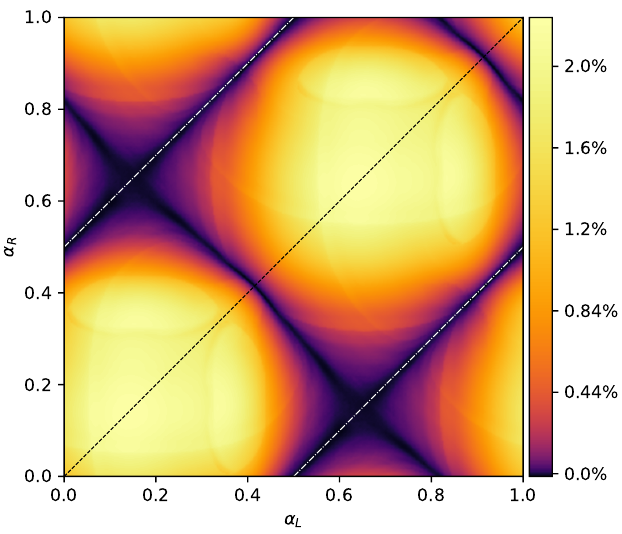
Figure 32 . Fraction of the total energy of initial con(cid:12)guration carried out by the radiation as a function of phases (cid:11) L and (cid:11) R of incoming exact oscillons for V = 0 : 93. The black dashed line corresponds to the set of all such symmetric con(cid:12)gurations and the white dot-dashed lines correspond to the set of all such anti-symmetric